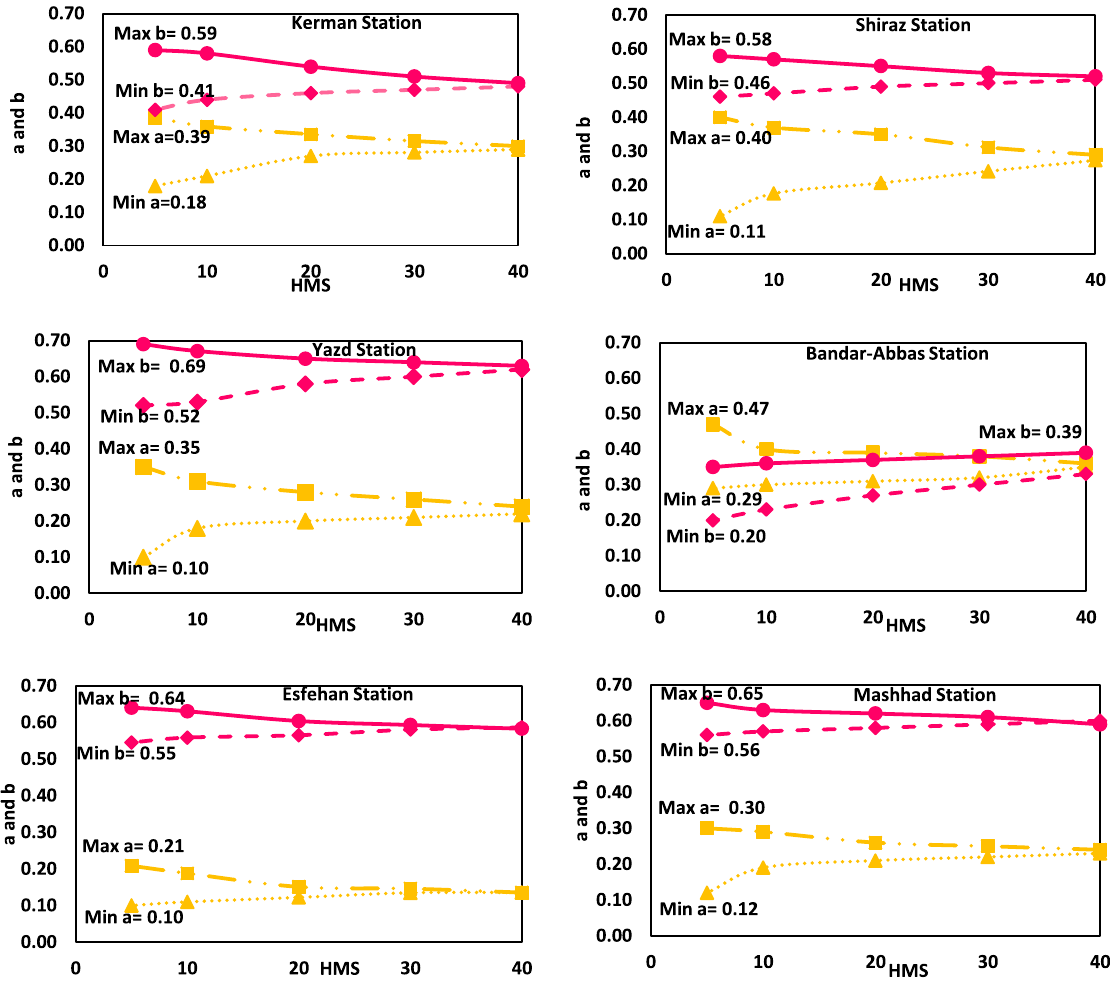
Figure 4. The minimum and maximum A–P model coefficients in Hs method, in different harmony memory size (HMS).